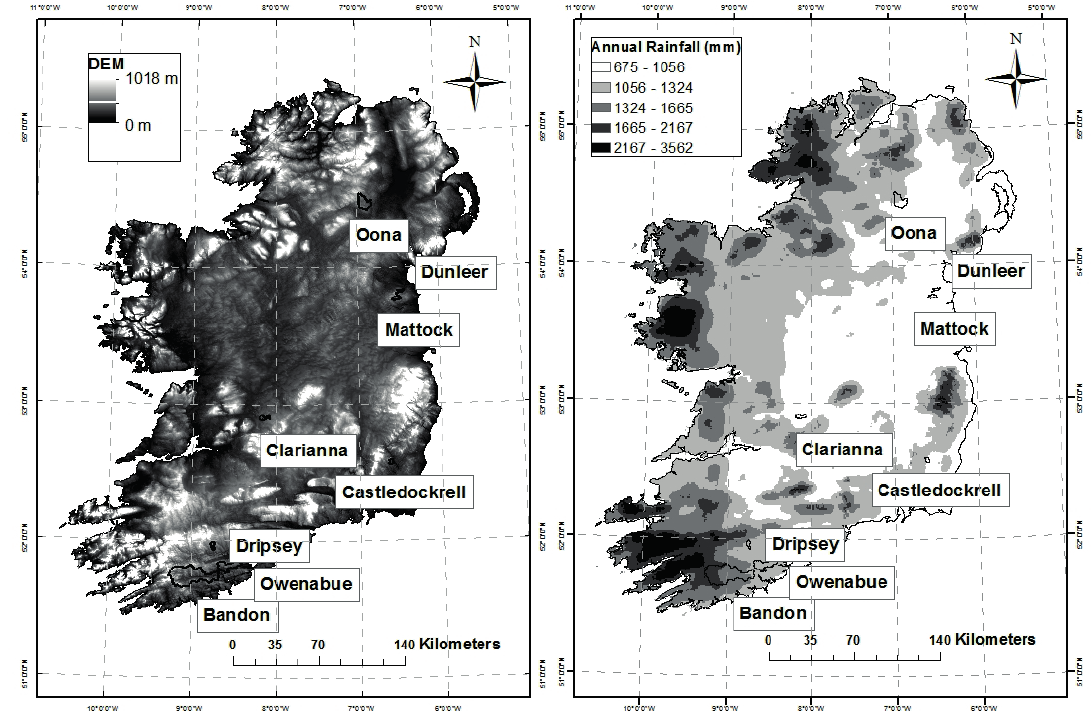
Fig. 1 Study catchments and corresponding topography and average annual precipitation pattern (data sources: EPA and Met Éireann). Note that both average annual precipitation, and rainfall seasonality, increases from east to west across Ireland (Walsh & Lawler,